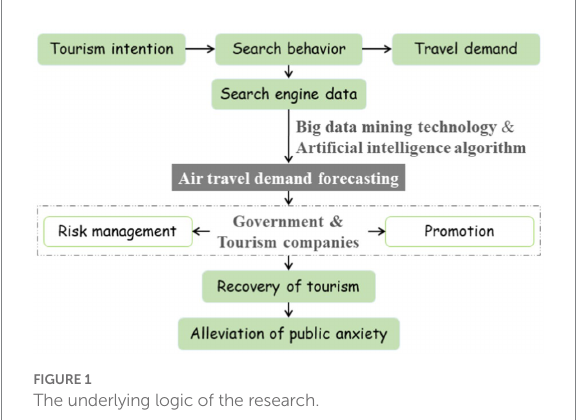
FIGURE 1 The underlying logic of the